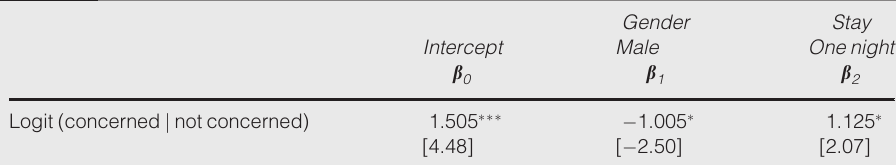
Table 4 Estimated results of ‘‘Concerned’’ as dependent variable against ‘‘Gender’’ and ‘‘Stay’’